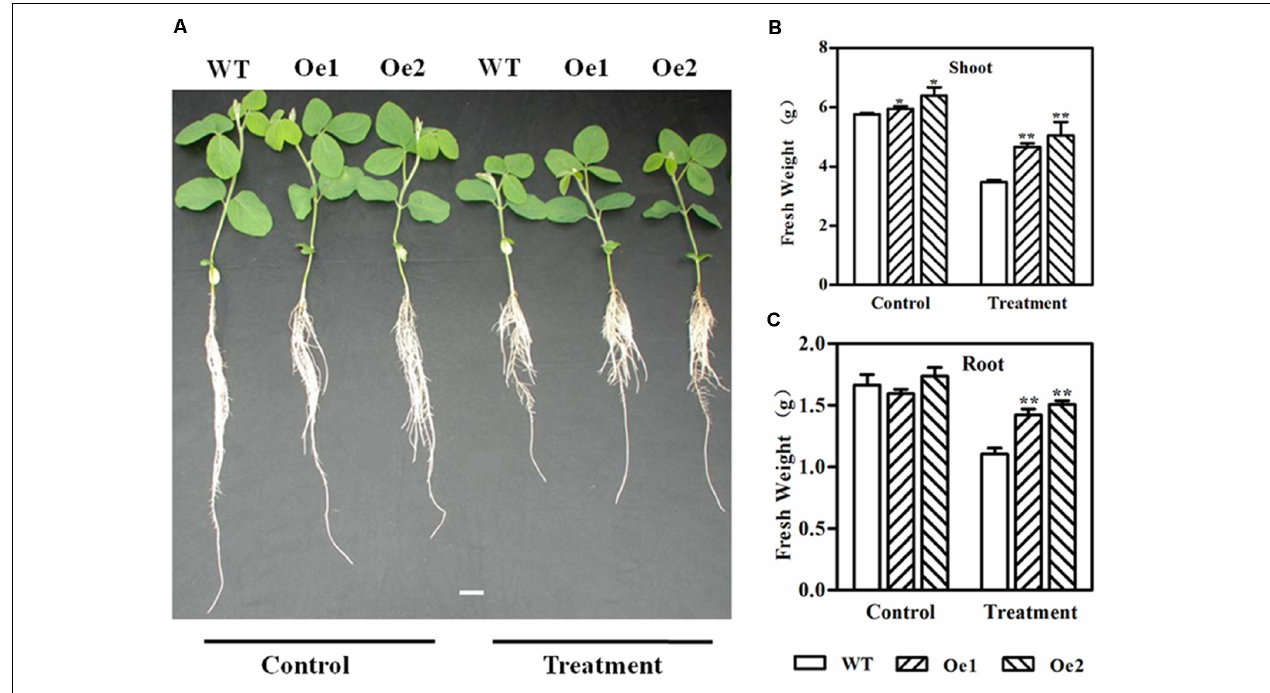
FIGURE 5 | Growth performance of wild-type (WT) and GmPIP2;9 -overexpression (Oe) plants under normal and polyethylene glycol (PEG)-mediated drought conditions. (A) Thirteen-day-old WT and GmPIP2;9 -Oe plants were treated with or without 20% PEG in culture media for 2 days, followed by a 5-day recovery. (B) Fresh shoot weight. (C) Fresh root weight. Data are means ± SD ( n = 3). ∗ P < 0.05 and ∗∗ P < 0.01.